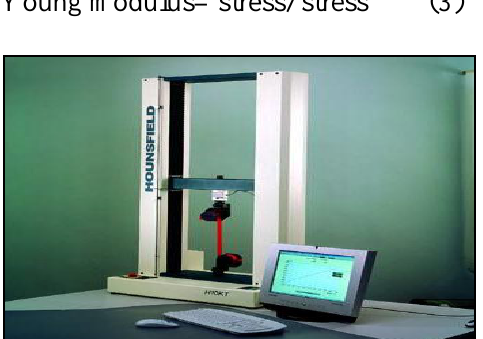
Fig.4: Tensile instrument.